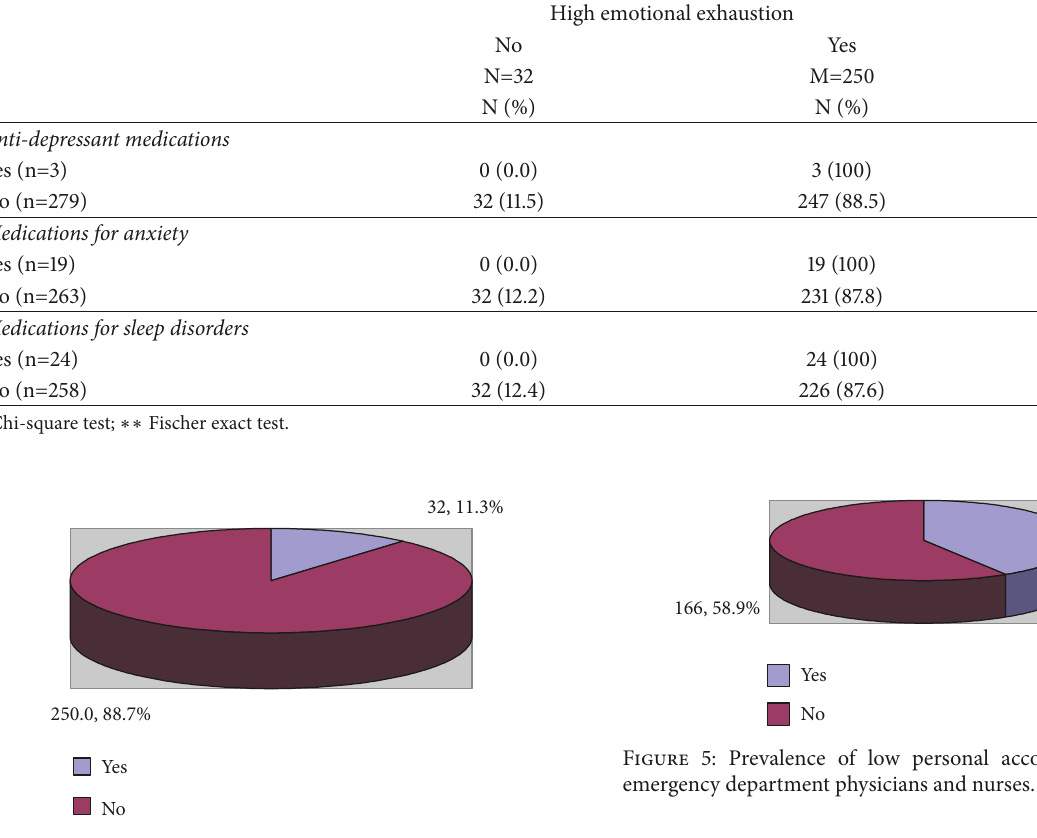
Figure 3: Prevalence of high emotional exhaustion among emer- gency department physicians and nurses.